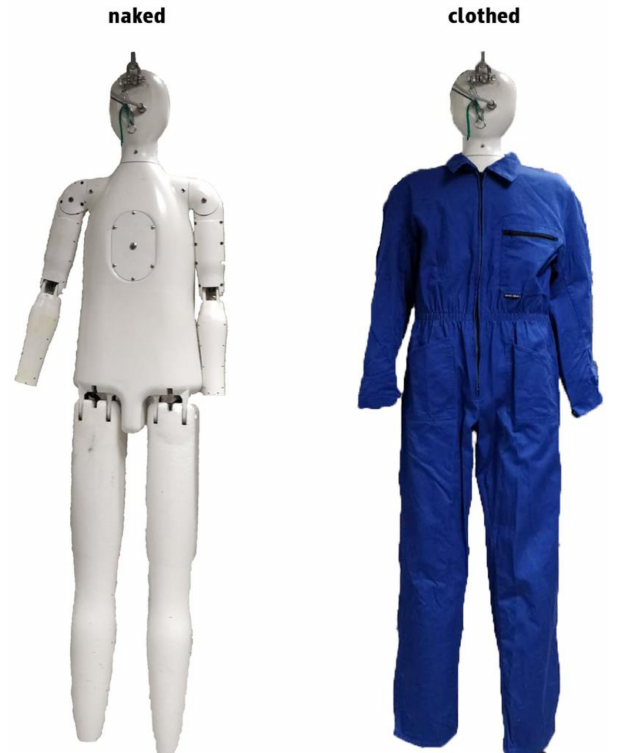
Figure A1. Determining the clothing insulation of the work coveralls used in our study using a thermal manikin.